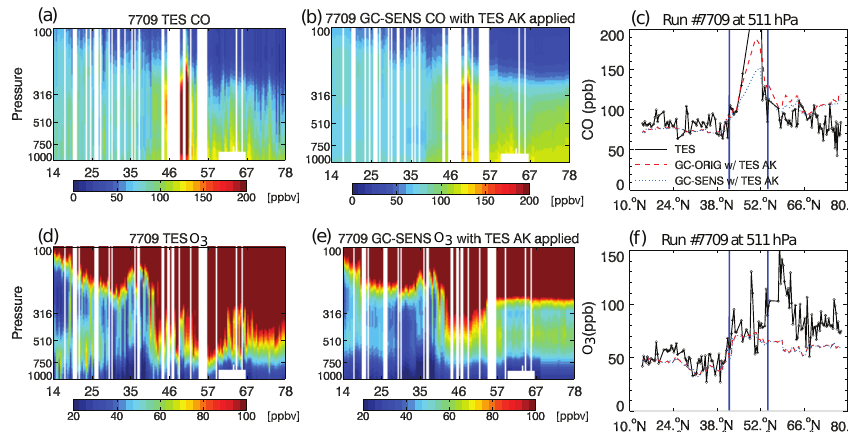
Fig. 13. Same as Figure 11 but for TES run 7706 on 3 July 2008.